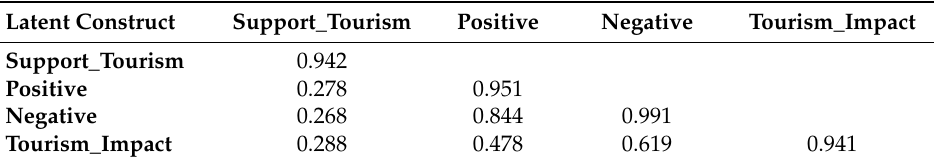
Table 2. Discriminant validity.